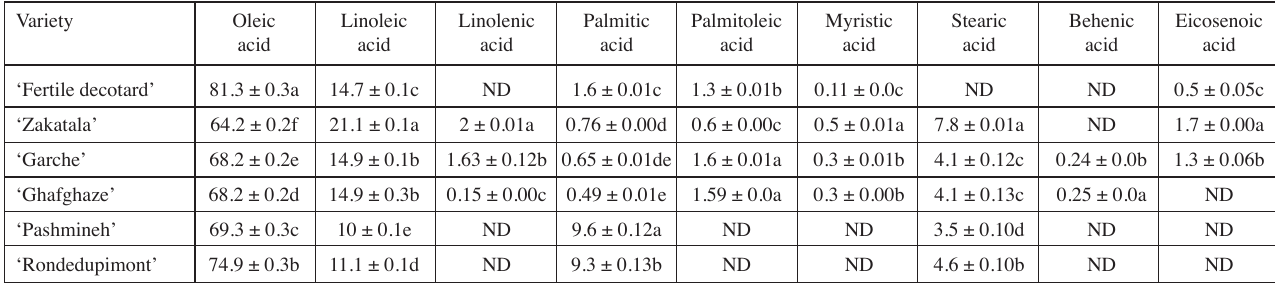
Tab. 2: Fatty acid contents (% of total oil) of hazlnuts ( Corylus avellana L.) varieties